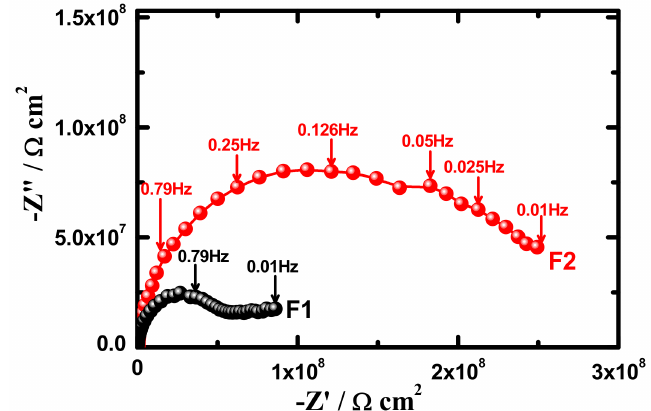
Figure 9. Nyquist plots for coatings F1 and F2 after 21 days’ immersion in the 3.5% NaCl